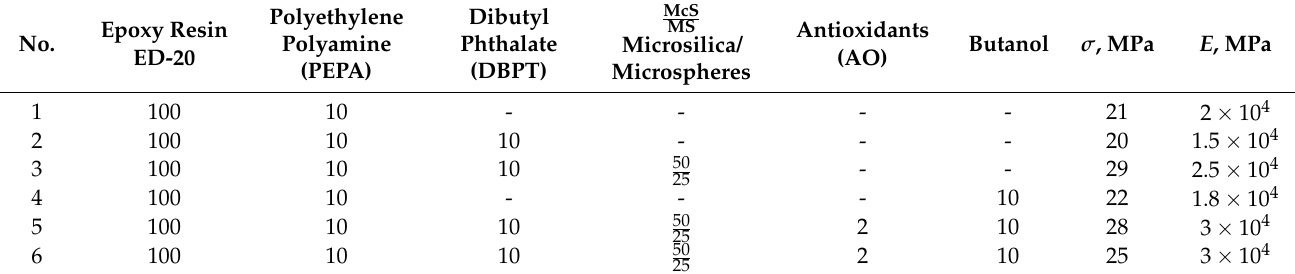
Table 1. Test compositions (in mass proportions) of epoxy compositions.